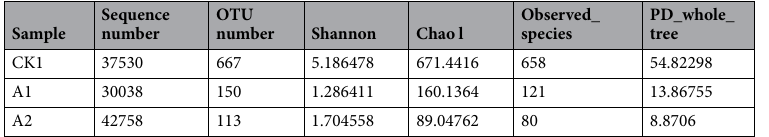
Table 1. Summary of the alpha diversity estimates in the samples.